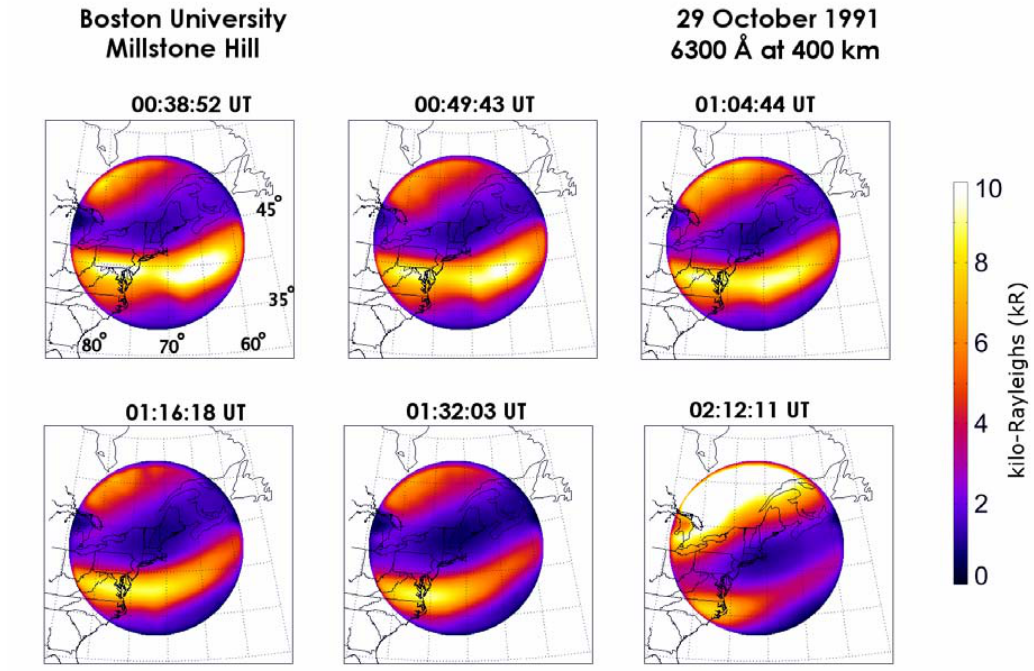
Fig. 4. A sample of the all-sky images at 6300 ˚A taken at Millstone Hill on the night of 29 October 1991. Observations above 15 ◦ elevation angle are mapped upon a geographic grid (“unwarped” from the fish-eye lens view) providing a 150 ◦ field of view (FOV) using an emission height of 400km appropriate for the SAR arc. Brightness units are in Rayleighs (R). The emissions to the north of the SAR arc are the diffuse Figure 4. A sample of the all-sky images at 6300 Å taken at Millstone Hill on the night aurora that occur near altitudes of ∼ 200km.